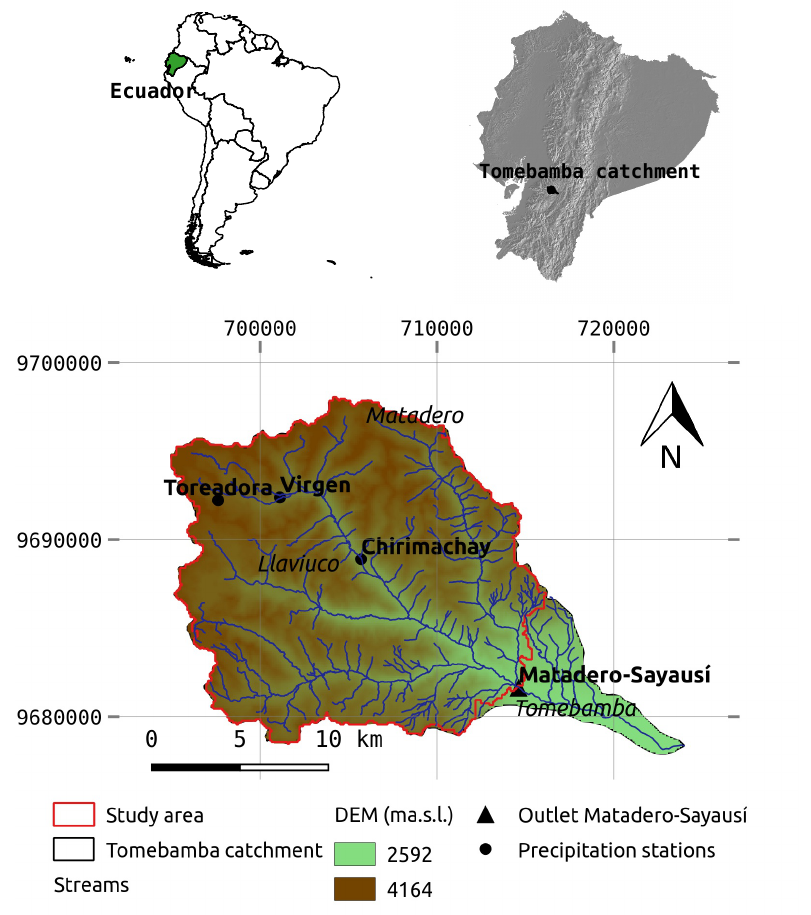
Figure 1. Location of the Tomebamba catchment at Matadero-Sayausí outlet in the Andean cordillera of Ecuador, South America (UTM